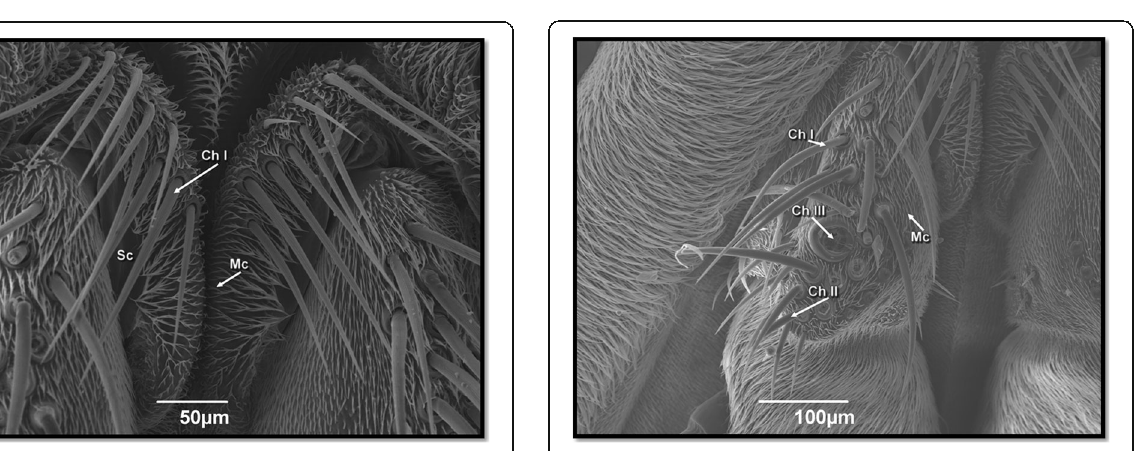
Fig. 9 Scanning electron micrographs showing the cuticular surface of pedicel of male of Mesembrinella semihyalina (× 220). Pe = Pedicel; ChI-III = chaetic sensilla I, II and III; Mc =